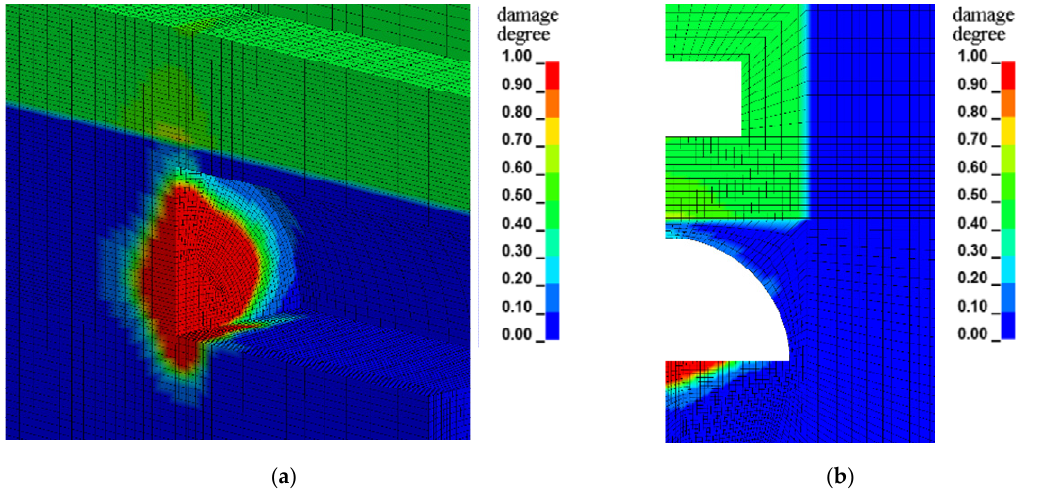
Figure 12. Blasting damage diagram of surrounding rock ( d = 3 m). ( a ) three-dimensional blasting damage diagram. ( b ) cross ‐ section blasting damage diagram.